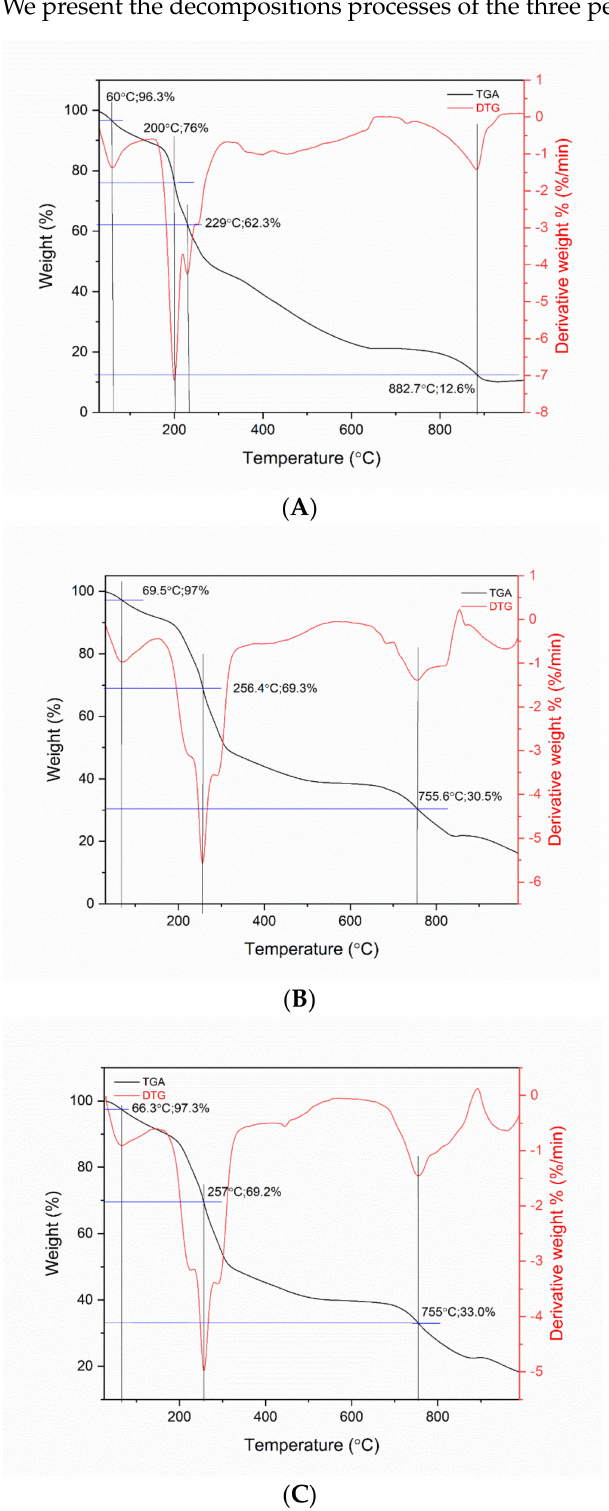
Figure 4. TGA curves of commercial pectin (PectaSol-C) ( A ), pectin extracted from xylanase ( B ), and a mixture of two enzymes ( C